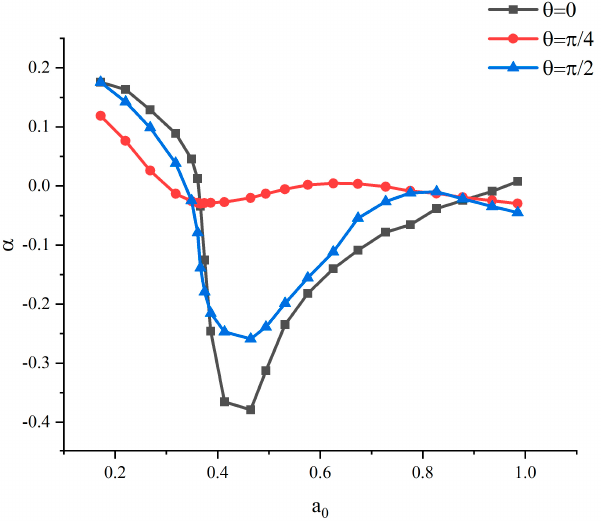
Figure 14. Pile–pile interaction under different incidence angles.